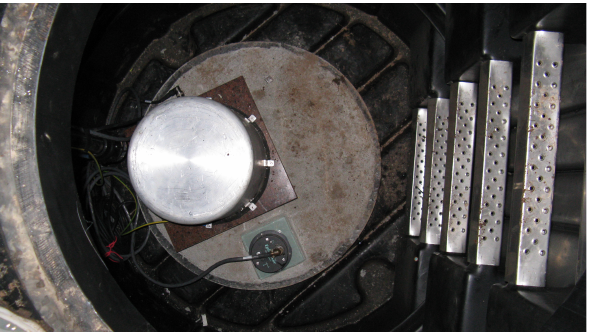
Fig. 4. Seismometers installed on a pier at the bottom of a plastic container, with extra thermal insulation (ZOU station).